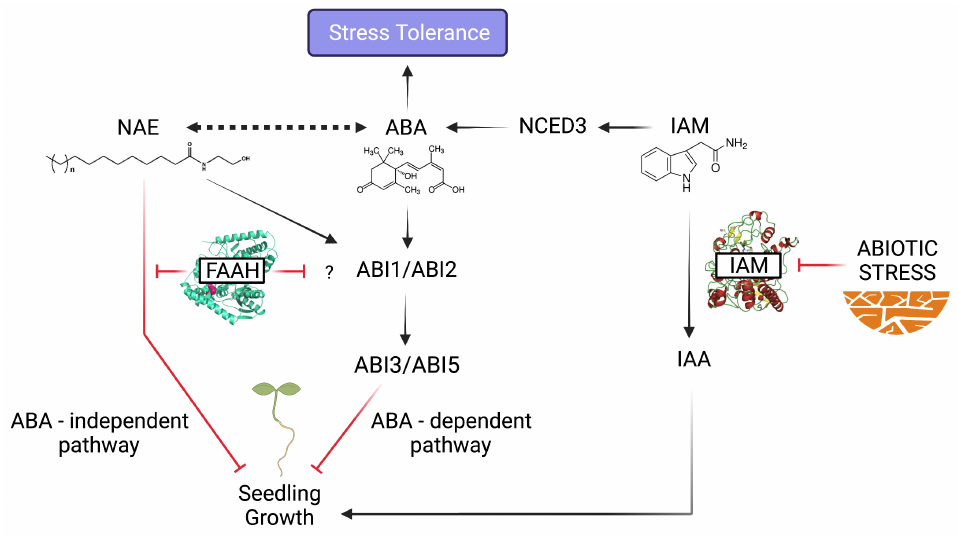
Figure 4. Schematic model integrating the converging growth inhibiting roles derived from NAE and IAM accumulated levels to trigger proper stress tolerance responses through ABA-dependent and -independent